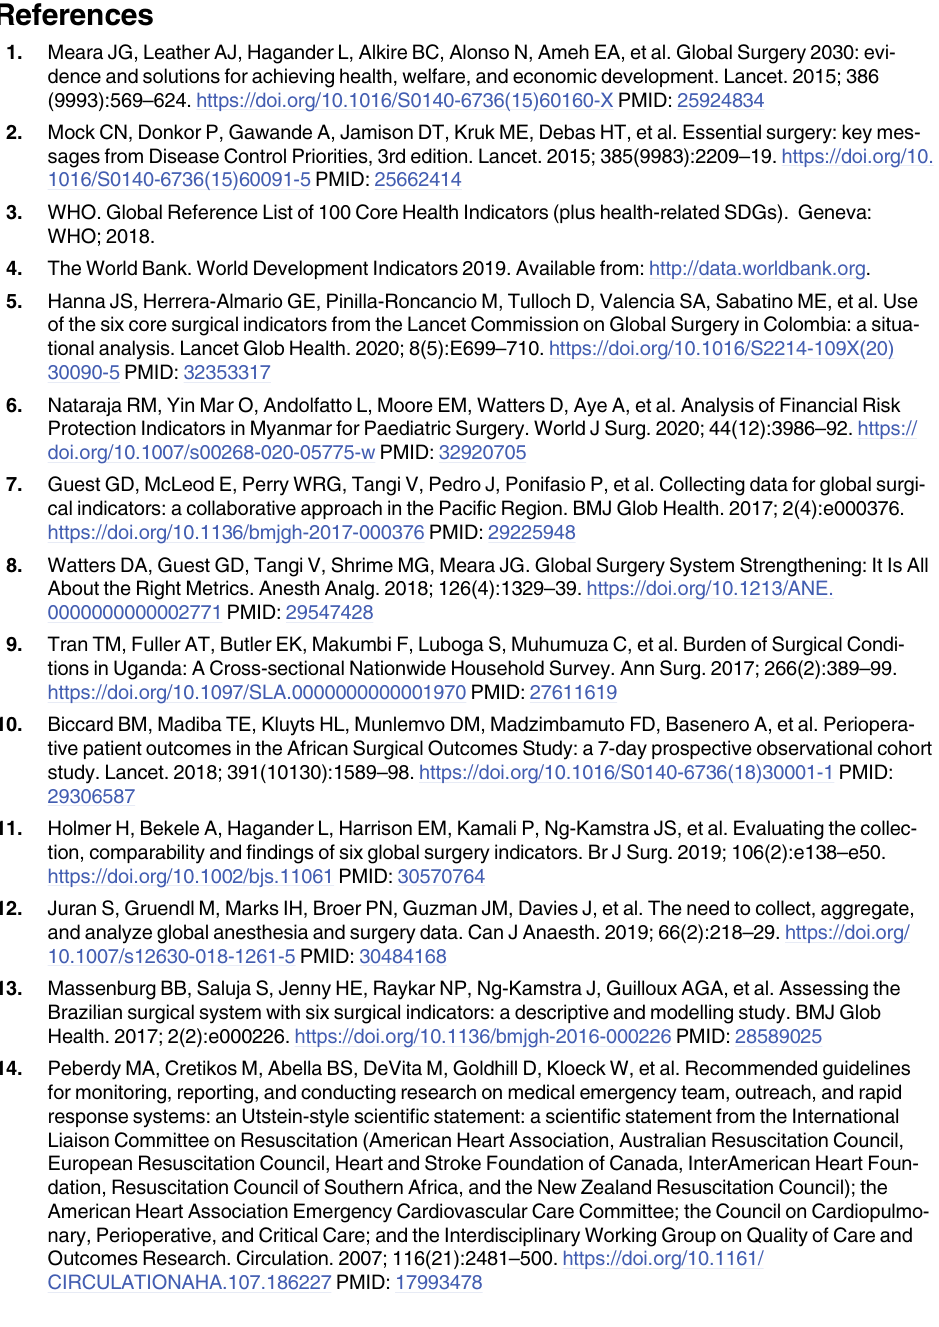
Table B . Working group leads and Steering Committee of the Utstein meeting. Text A . Points of Disagreement. Tables C-G . Basic, intermediate, and full sets of data points for each indica- tor as well as current data